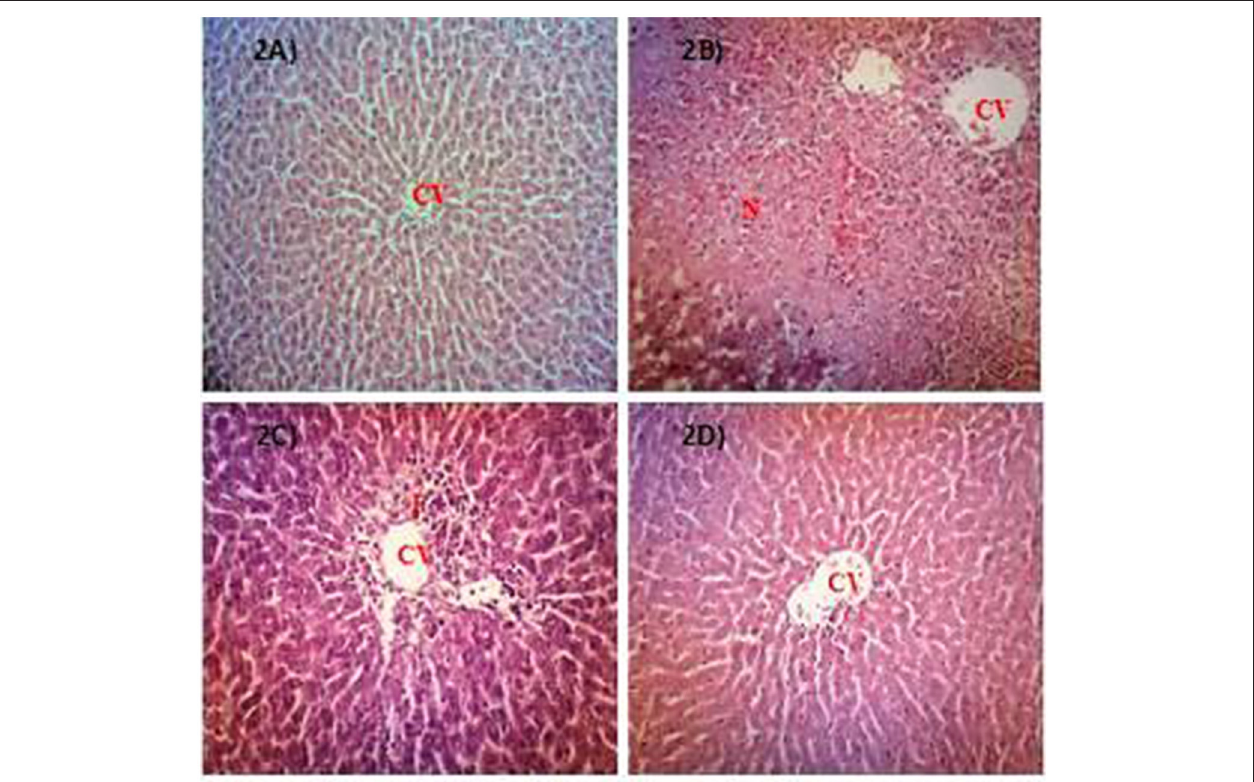
FIGURE 2 | Microscopic examination of PCM-intoxicated rat’s liver tissues pretreated orally with 50, 250, and 500 mg/kg AQMC. Photomicrographs show the liver tissue section of: (A) normal group (untreated), which showed normal liver architecture consisting of normal hepatocytes (NH) and central vein (CV); (B) hepatotoxic group (orally treated with only 3 g/kg PCM), which shows massive necrosis (N), hemorrhage (H) and inflammation (I); (C) positive group (orally pre-treated with 50 mg/kg NAC followed by PCM), which showed preservation of NH with mild I; (D) 500 mg/kg AQMC-pretreated group followed by PCM, which showed normal liver architecture with no significant changes observed. Groups pre-treated with 50 or 250 mg/kg AQMC followed by PCM showed only mild I (data not shown). 100x magnification, CV, central vein; N, necrosis; I, inflammation.